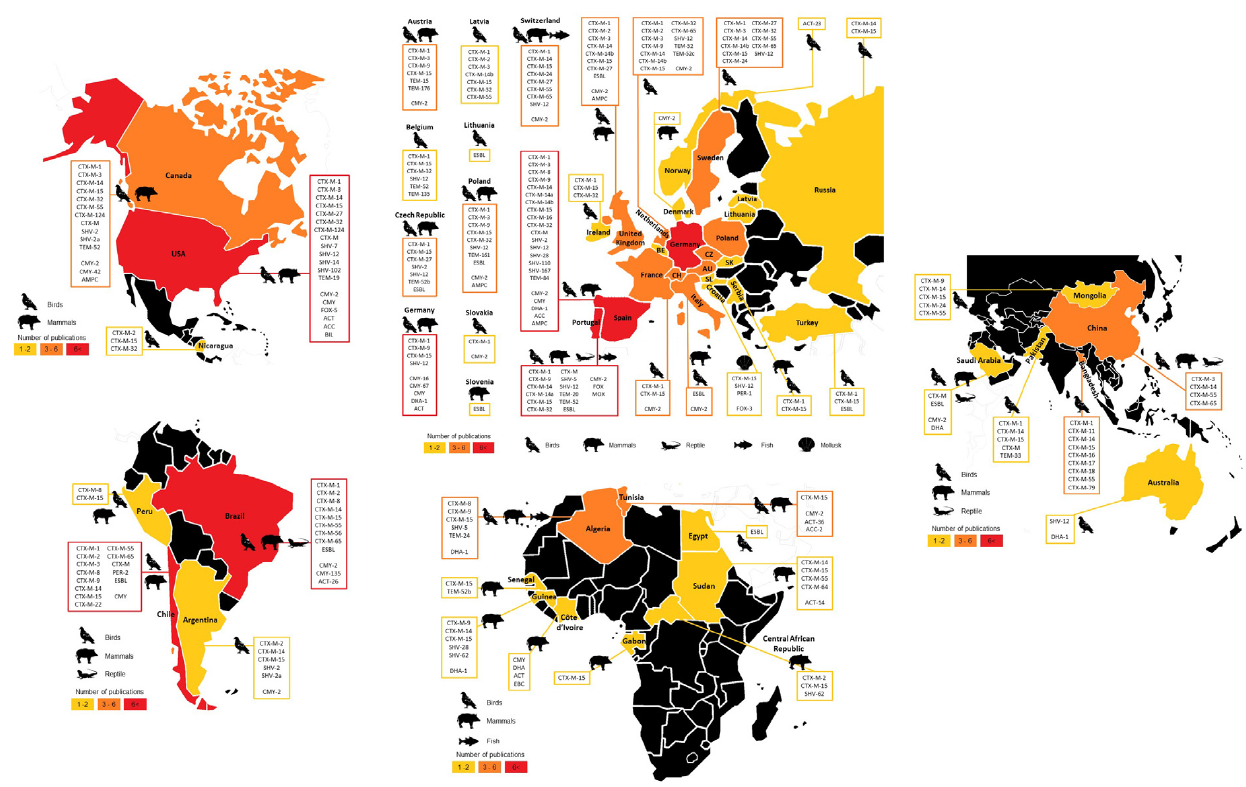
Figure 6. Maps of North and Central America ( top left ), South America ( bottom left ), Europe ( top center ), Africa ( bottom center ) and Asia and Oceania ( right ) showing the animal host and cephalosporinases subtypes described in the selected publications per country.